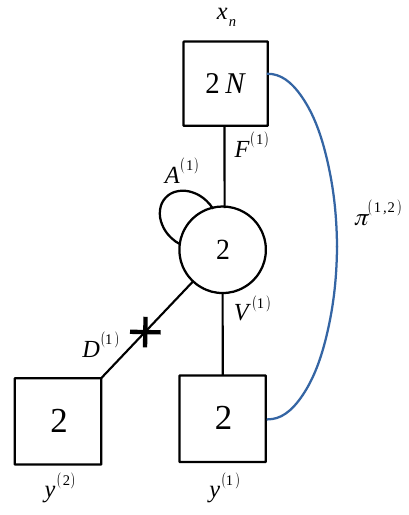
Figure 18 . The quiver diagram representation of E